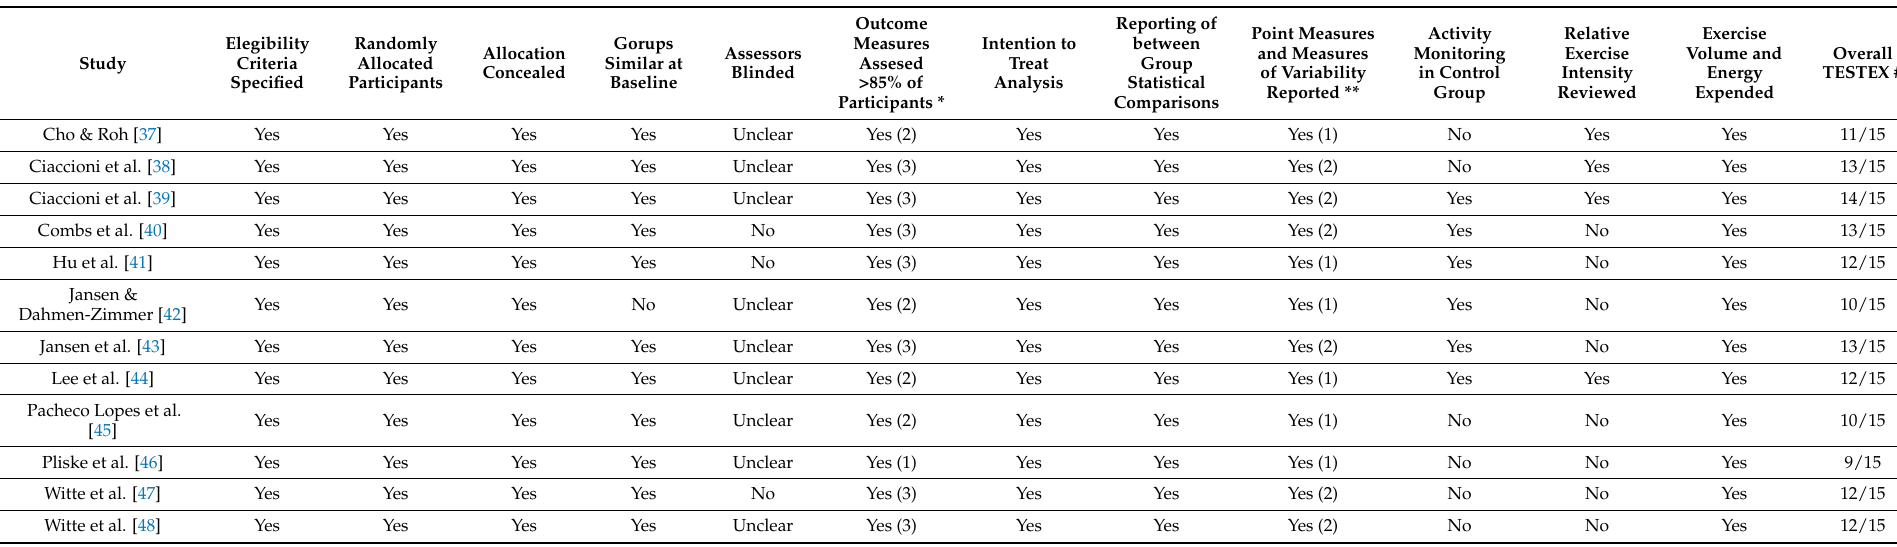
Table 1. Study quality assessment according to TESTEX